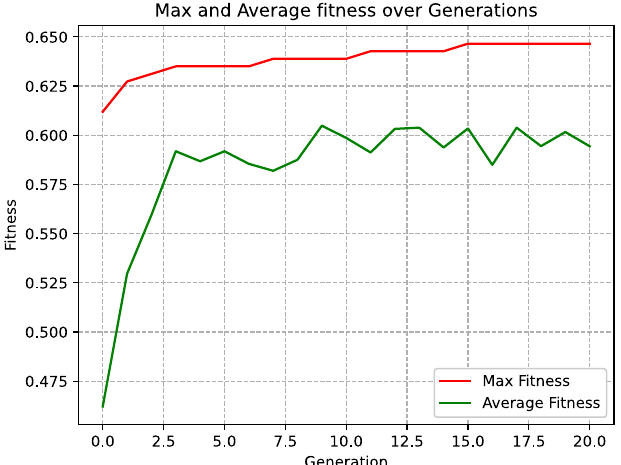
Figure 6. Iterative Algebra and